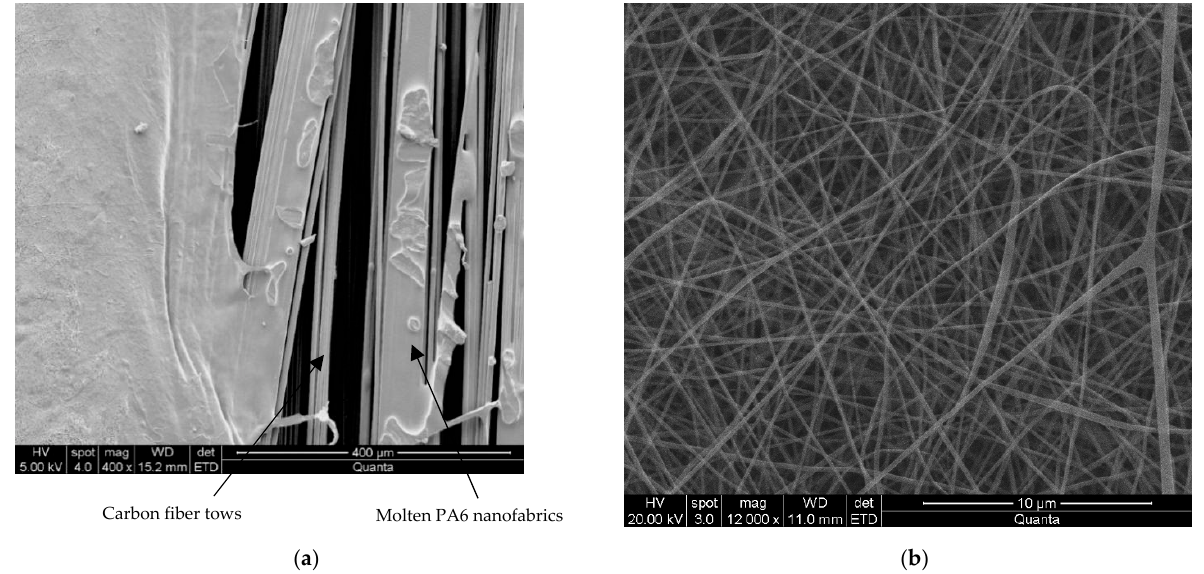
Figure 12. SEM imaging of ( a ) the interface between the weld and the adjacent nanofabric and ( b ) the nanofabric structure prior to consolidation.